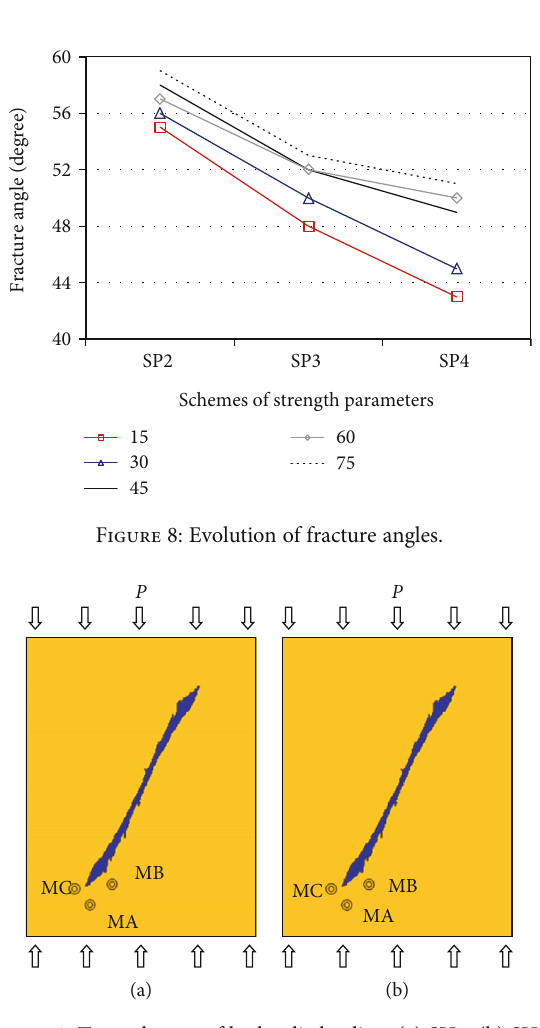
Figure 9: Two schemes of hydraulic loading: (a) SH1; (b)